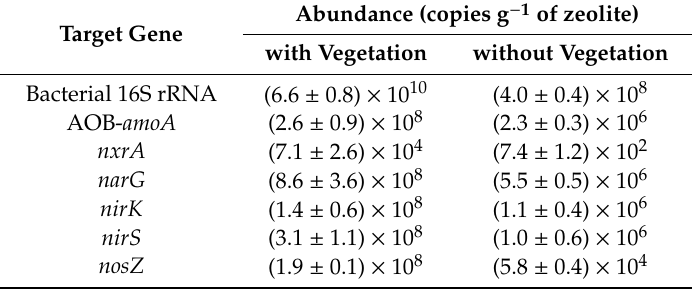
Table 1. Abundance of bacterial 16S rRNA and ammonia oxidizing bacteria (AOB)- amoA , nxrA , narG , nirK , nirS , and nosZ genes in zeolite-based tidal flow CWs with and without vegetation (common reed plants) on the last day (i.e., 60th day) of operation. Average numbers of gene copies ±SD are shown for triplicate experiments.